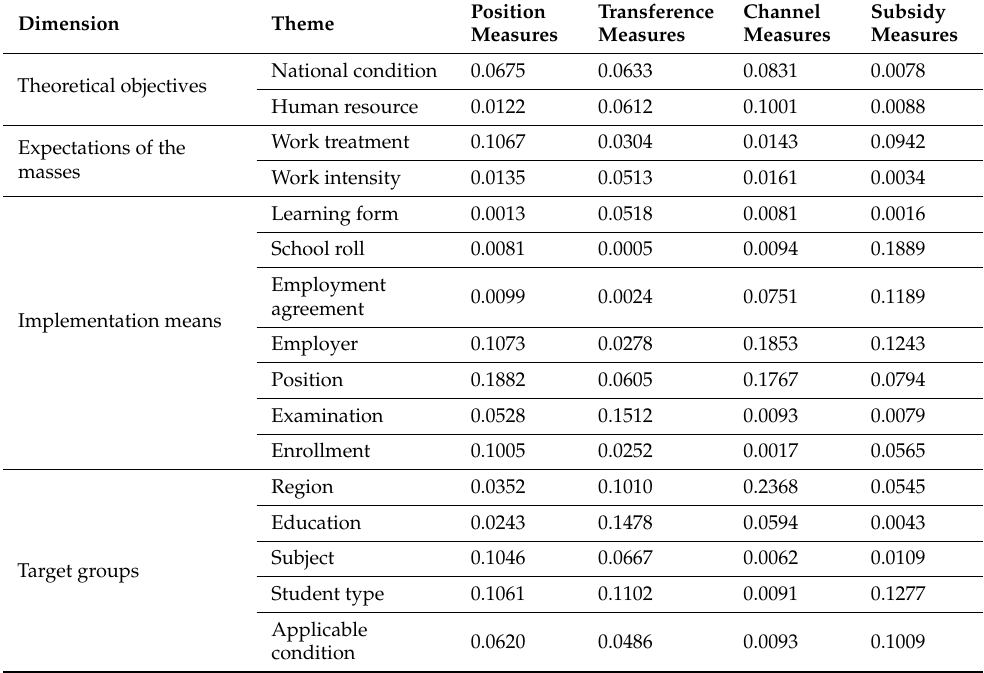
Table 10. Weight of policy